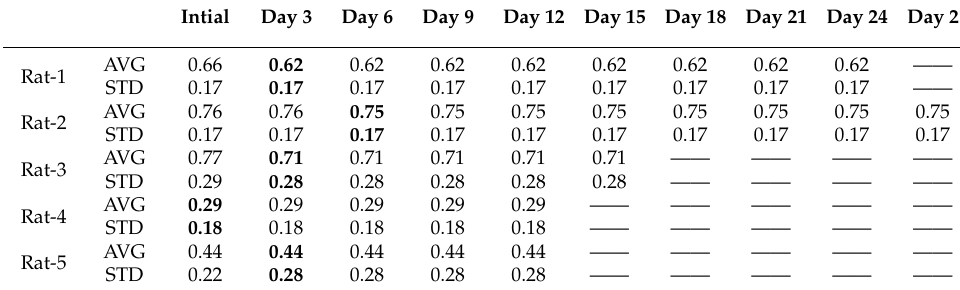
Table 3. Threshold